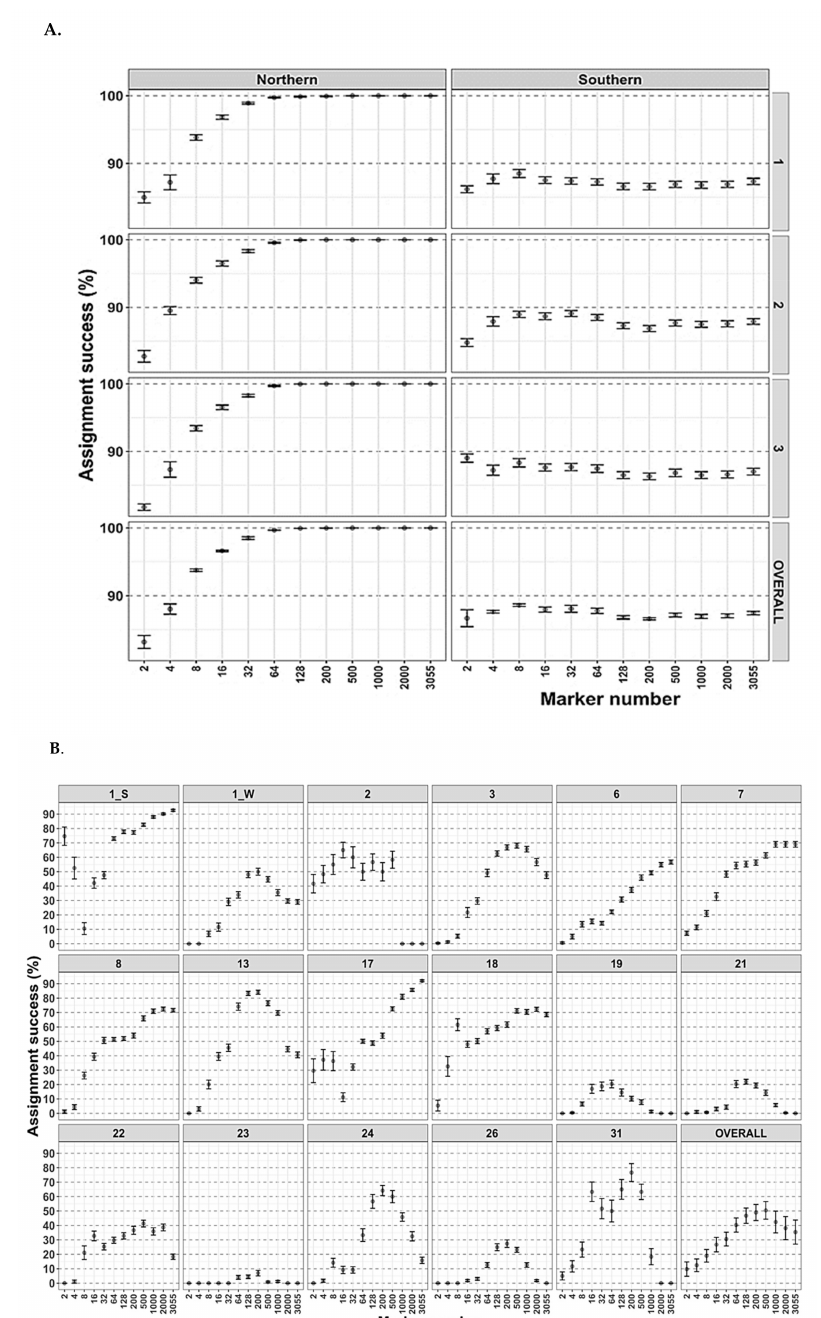
Figure 4. Di ff erent numbers (chosen as ~2 n, where n = 1 to 11) of single nucleotide polymorphisms (SNPs or DNA markers) as indicated by marker number were used to assign Arctic char samples to clusters representing either presumed populations or fishing locations. ( A ). Fish were assigned to “Northern” (left column) or “Southern” (right column) clusters, showing overall assignment success (y-axis) depending on the number of markers used and with the subsampling repeated three times as indicated by the successive stacked panels. Overall assignment success within the same cluster are shown on the bottom panel. ( B ). Arctic char were assigned to fishing site locations (indicated by site number according to Table 1, with fish at site 1 shown as spring- or winter-netted fish, 1_S or 1_W, respectively). Assignment success is shown relative to the number of markers used. An additional last panel shows the overall success of pooled results among sites. Similar figures analyzed with missing data imputed are found in Supplementary Materials Figure